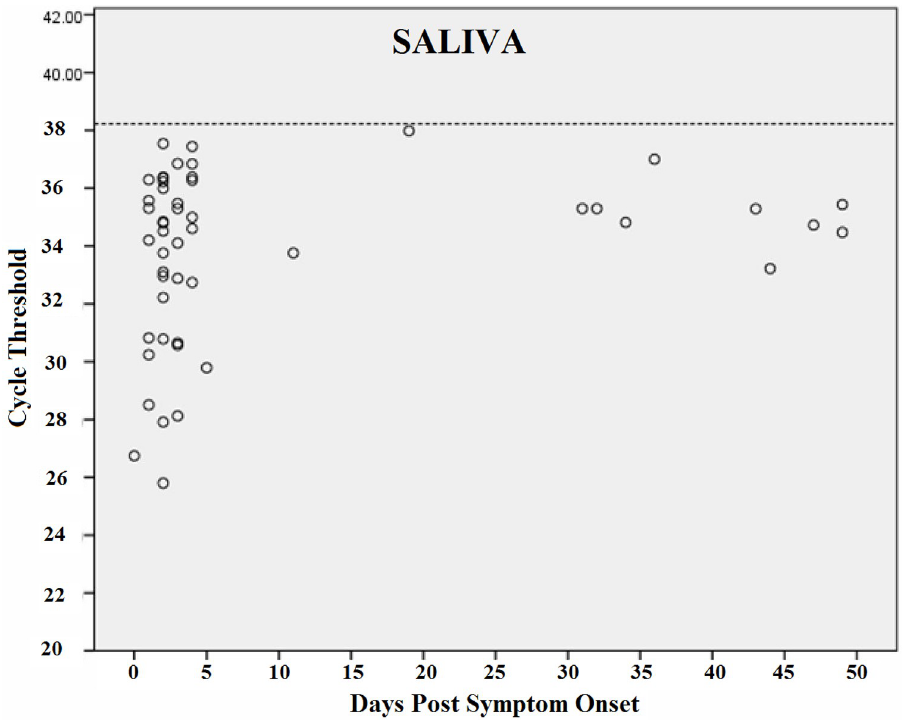
Fig 8. CHIKV Cycle Threshold (Ct) by days after the onset of symptoms in